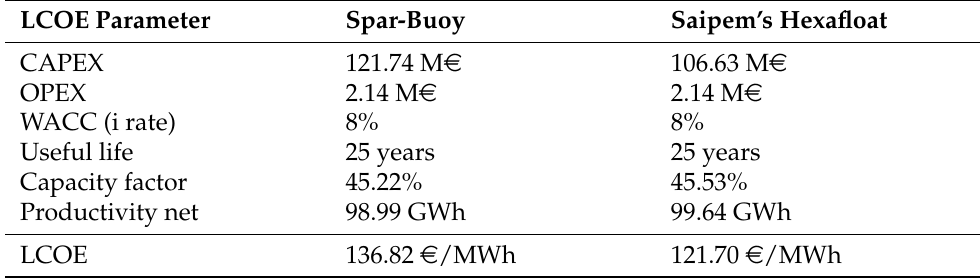
Table 7. LCOE internal parameters for the two platform